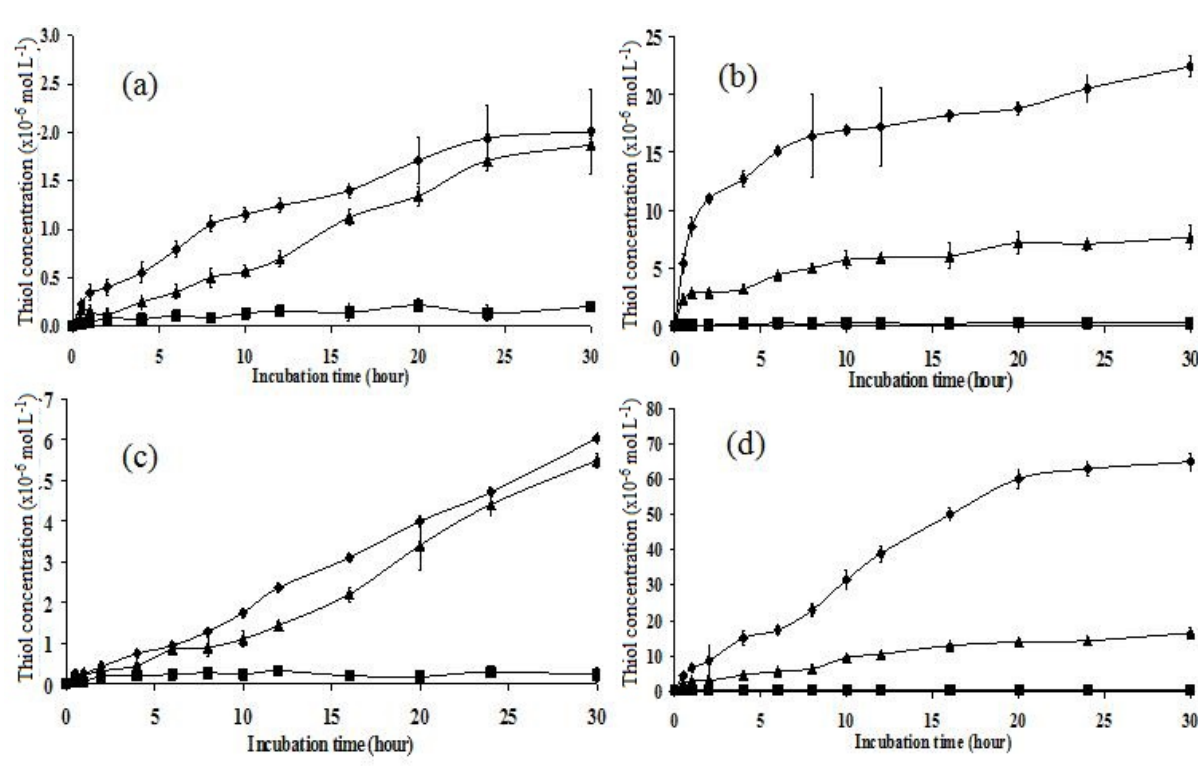
Figure 7. Thiol concentration as a function of incubation time in phosphate buffer medium over a 30 h time period in polymers ( a ) P10; ( b ) P11; ( c ) P151; and ( d ) P15. Mean ± SD, n =